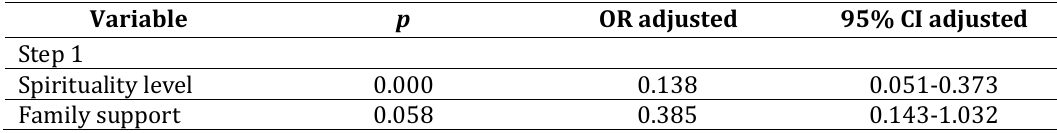
Multivariate analysis of independent variables with spiritual self-care behavior Variable Step